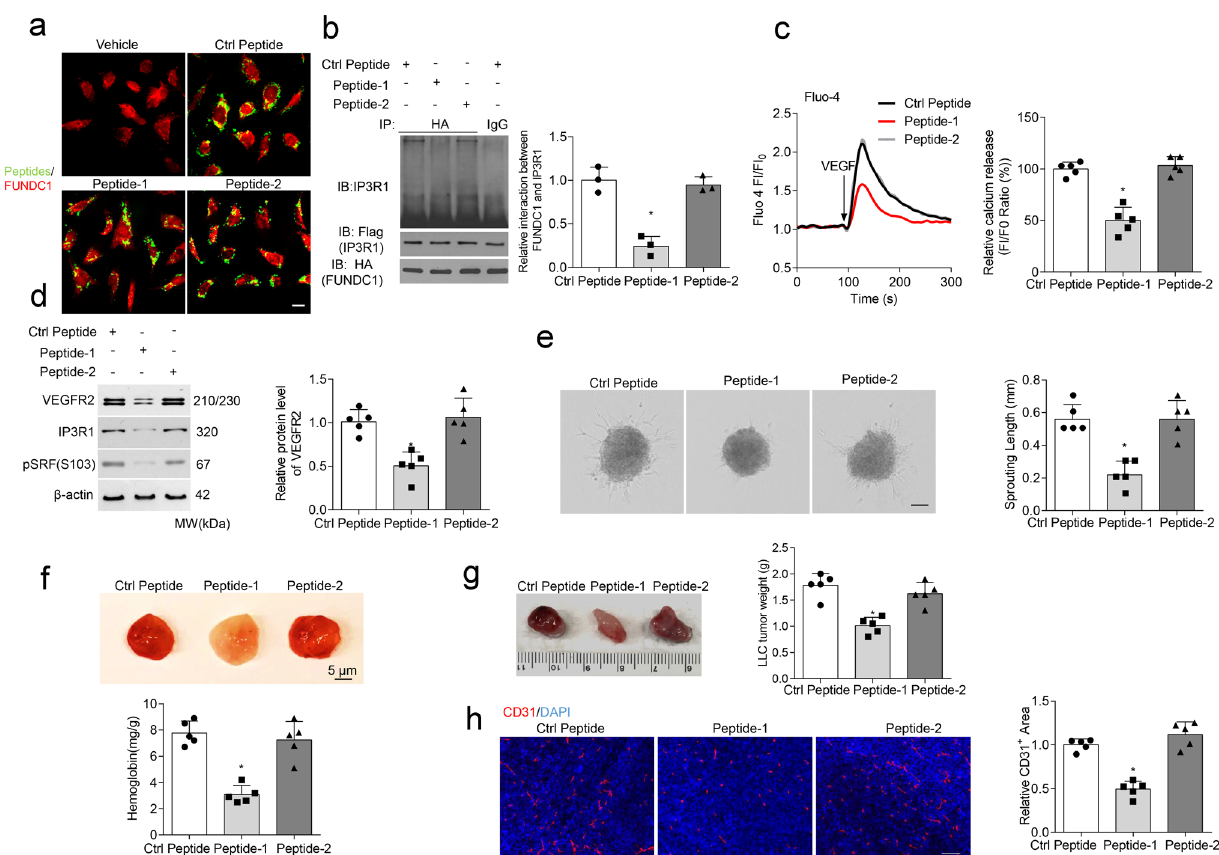
Fig. 6 A speci fi c therapeutic peptide blocks the FUNDC1 – IP3R1 interaction and angiogenesis. a Transduction ef fi ciency of peptides 1, 2, and a control peptide in Human umbilical vein endothelial cells (HUVECs) ( n = 5 independent experiments). b HUVECs were treated with different peptides (20 μ M) for 24 h, then subjected to immunoprecipitation with antibody against FUNDC1(HA) to quantify the interaction of FUNDC1 and IP3R1 ( n = 3 independent experiments). c HUVECs were treated with different peptides (20 μ M) for 24 h, then cytosolic Ca 2 + was detected using the fl uorescent probe Fluo-4, AM ( n = 5 independent experiments). d HUVECs were treated with different peptides. After 24 h, the cell lysates were collected and subjected to western blot assays to detect the expression of VEGFR2, IP3R1, SRF, and phosphorylated SRF at Ser103 (pSRF) ( n = 5 independent experiments). e Three-dimensional spheroids and representative images of spheroid-sprouting were analyzed ( n = 5 independent experiments). Scale bar, 100 µ m. f Matrigel containing vascular endothelial growth factor (VEGF) was injected subcutaneously into 6-week-old wild-type mice, then the mice received an intravenous injection of the indicated peptides. After 10 days, matrigel plugs were removed for analysis of new vessel formation by histological and Hb assay ( n = 5 mice/group). Quanti fi cation of Hb extracted from matrigel plugs of different groups. g C57BL/6 mice with LLC tumors that were approximately 90 mm 3 in size were treated with intravenous injections of different peptides (10 mg/kg/3 days). After 28 days, the tumors were harvested and quanti fi ed. Representative images of tumors ( n = 5 mice/group). h Immunostaining of LLC tumor sections and quanti fi cation of relative CD31-positive area. ( n = 5 mice/group). Scale bar, 100 µ m. Statistical signi fi cance was assessed using one-way ANOVA with post hoc multiple comparisons test for multiple groups. *p < 0.05 vs Ctrl peptide. All values are mean ±